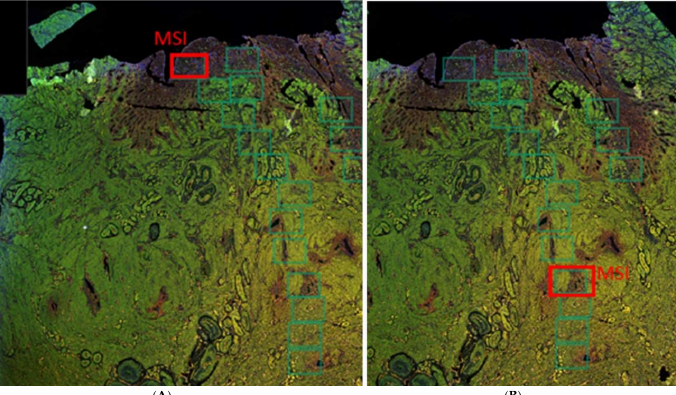
Figure 9. Examples of Phenochart™ whole slide image viewer and the selection of multispectral image (MSI) areas of interest (green rectangles) of eutopic endometrium (red rectangle on panel ( A )) and ectopic endometrium (red rectangle on panel ( B )) after multicolor IHC staining of an adeno- myosis